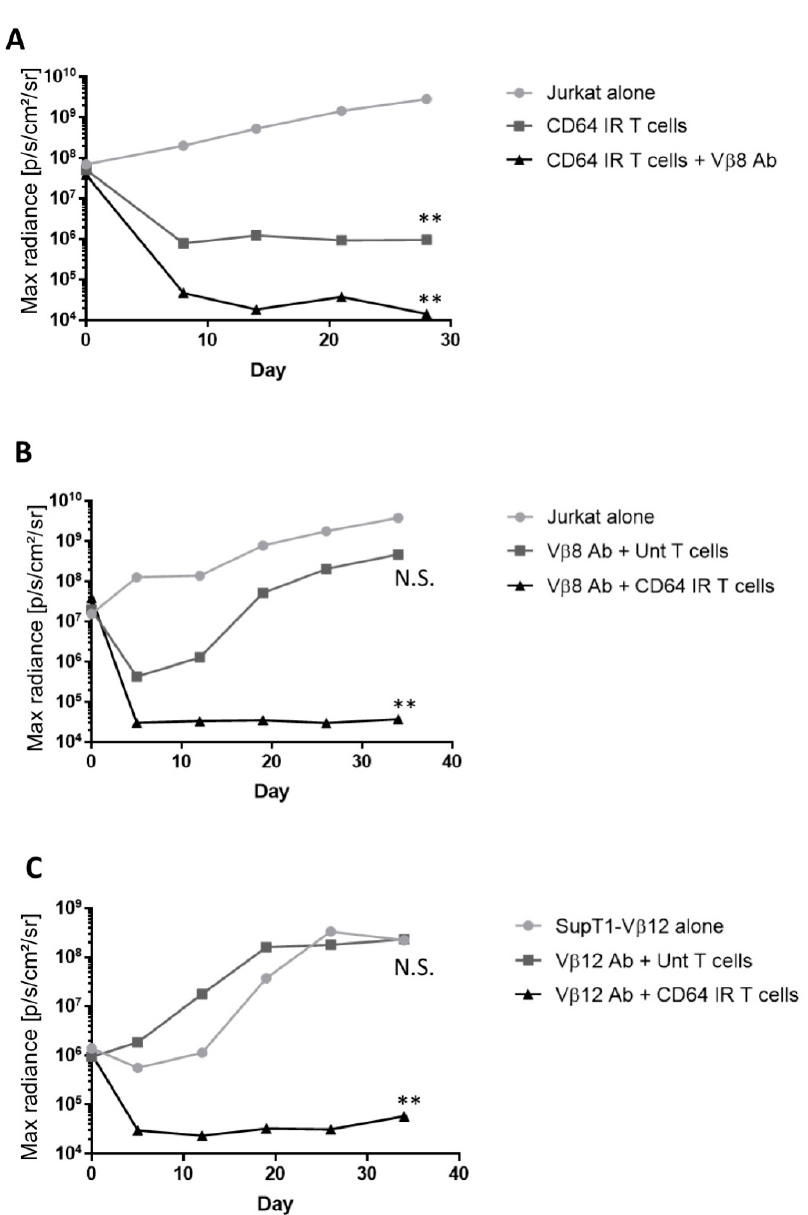
Figure 3. V β antibody in conjunction with CD64 IR T cells prevents T cell malignancy outgrowth in vivo. Winn assays are performed by subcutaneous injection of malignant T cell line, V β antibody, and T cells as indicated in immunodeficient mice. Median radiance is graphed and significance level indicated by asterisks are in reference to the malignant T cell line only control. ( A ) A pilot Winn assay of CD64 IR T cells and V β 8 antibody with the Jurkat T cell line. Two mice per group. ( B ) Winn assay of CD64 IR or untransduced T cells and V β 8 antibody with Jurkat T cell line. Five mice per group. ( C ) Winn assay of CD64 IR or untransduced T cells and V β 12 antibody with the engineered SupT1-V β 12 T cell line. Five mice per group. Against the Jurkat cell line, co-administration of CD64 IR T cells slowed the growth of the Jurkat cells compared to mice given tumor only. Addition of V β 8 antibody was seen to further inhibit tumor growth in this experiment. In all experiments, groups given V β antibody in conjunction with CD64 IR T cells resulted in statistically significant decreased tumor growth. Administration of untransduced cells in conjunction with V β antibody did not significantly affect tumor growth. Asterisk coding in figures is as follows: * p ≤ 0.05; ** p ≤ 0.01; *** p ≤ 0.001.